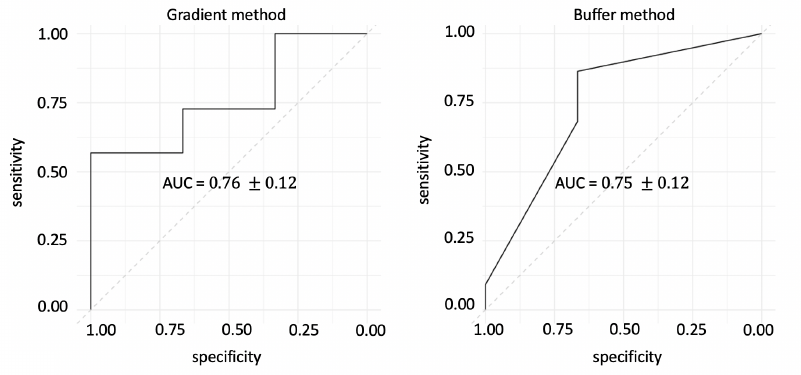
Figure 10. The classification performance in terms of AUC for both gradient ( left ) and buffer ( right ) methods for the descending